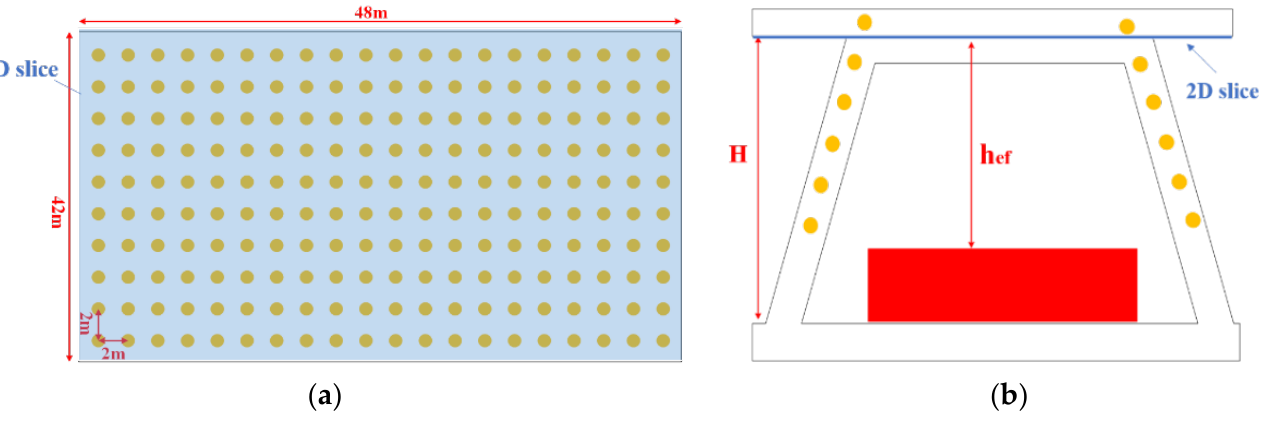
Figure 2. Thermocouple distribution in the truss and ceiling of double-deck bridge model: ( a ) bottom of ceiling; ( b ) inner surface of truss.